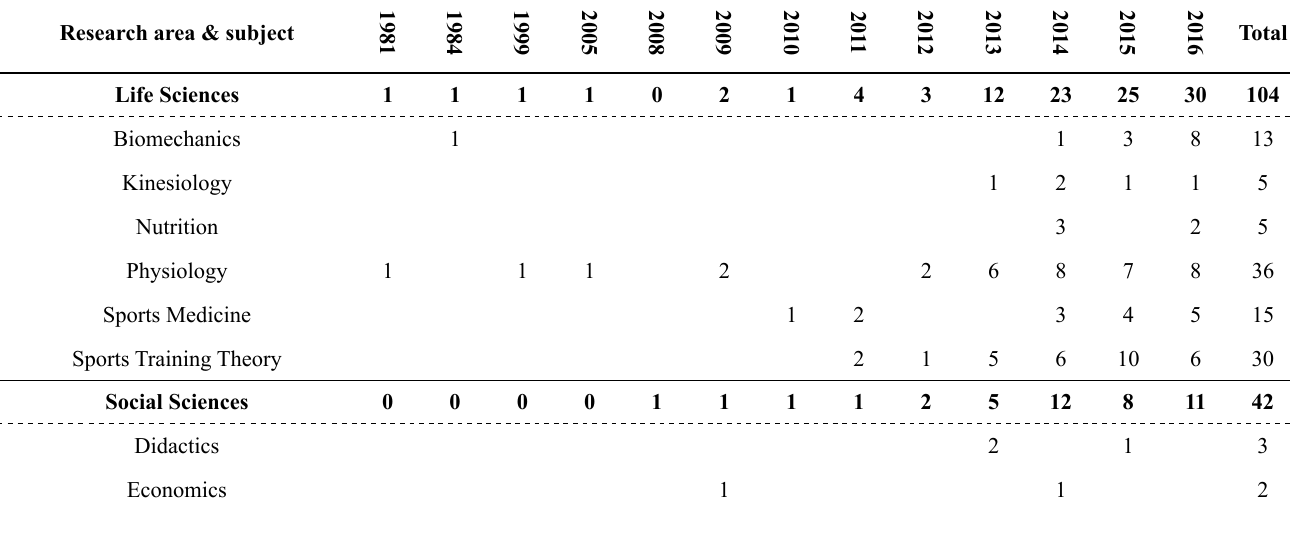
Table 1- Frequency distribution of published articles by year of publication, research area and subject. Research area &